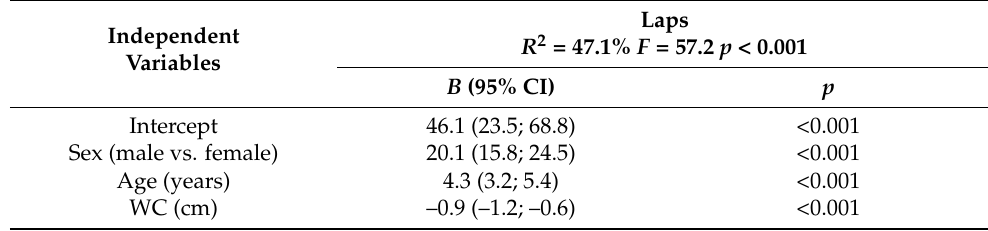
Table 5. Results of regression analysis: sex and age vs. fitness test results (number of